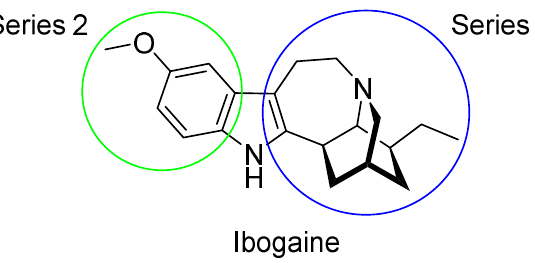
Figure 1. Series 1 and 2 derived from ibogaine.